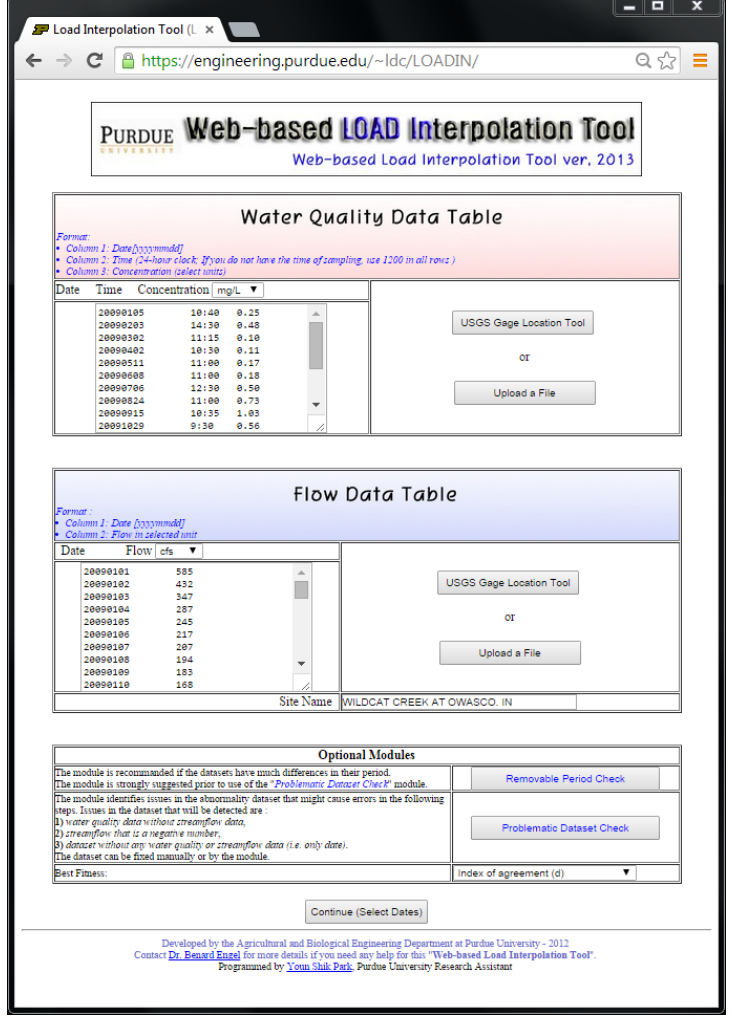
Figure 1 . LOADIN interface for streamflow and water quality data